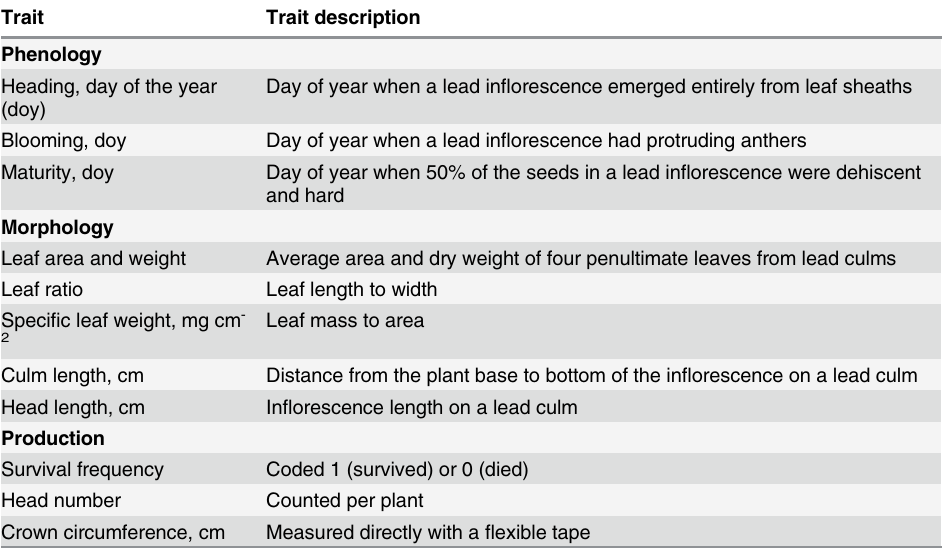
Table 1. Plant traits measured on basin wildrye plants in common gardens at Central Ferry and Pull- man, WA. Trait Trait